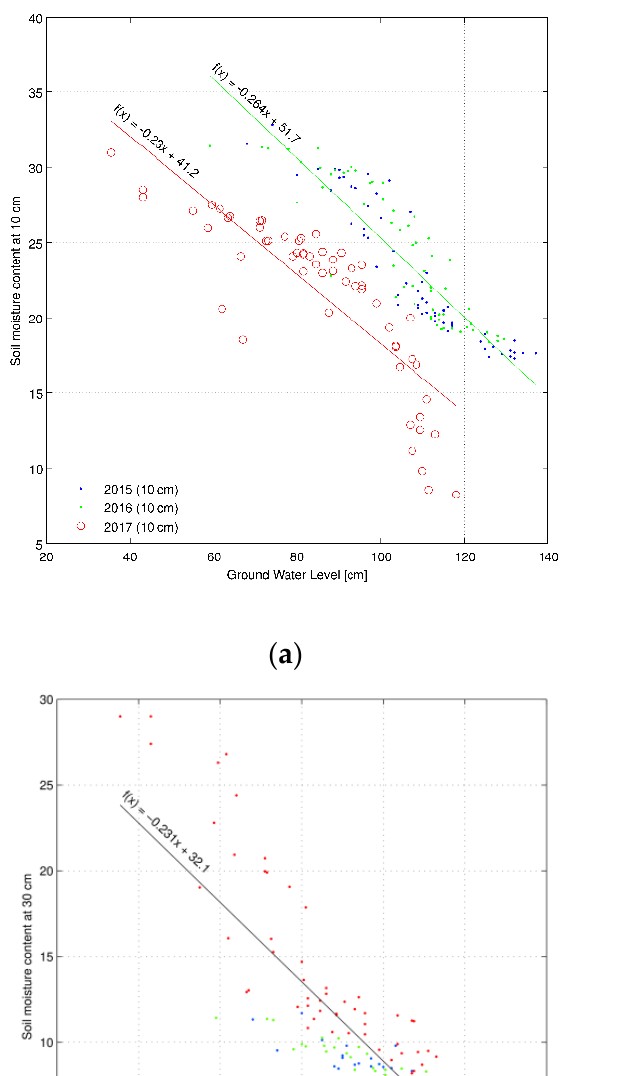
Figure 9. Spatiotemporal distributions of soil moisture content and pressure head in vegetation periods 2015, 2016, and 2017.